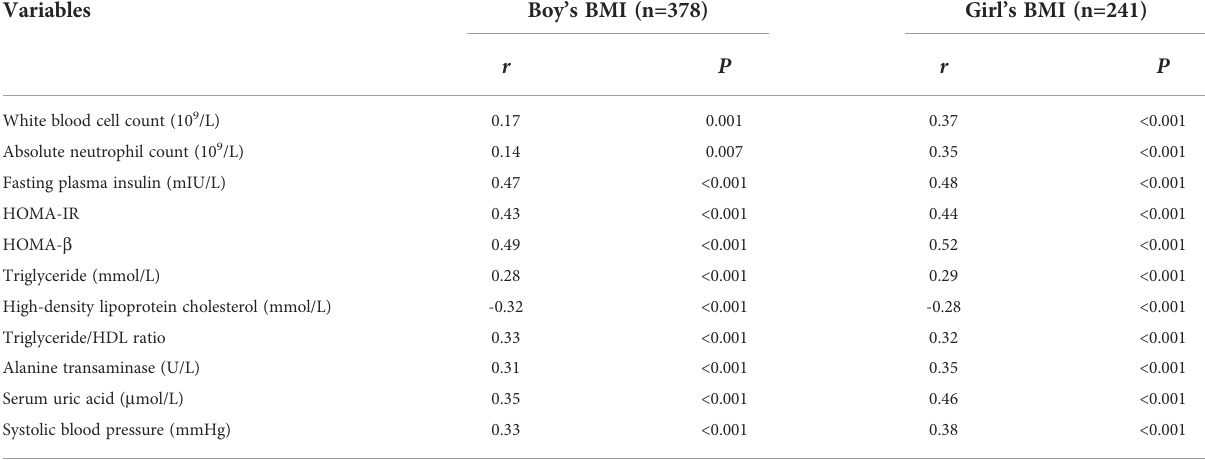
TABLE 3 Sex differences in partial correlation analysis of BMI and clinical indicators adjusted for age in children with overweight and